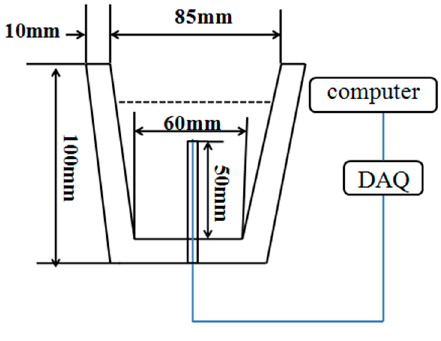
Figure 2. Diagram of the thermal analysis.